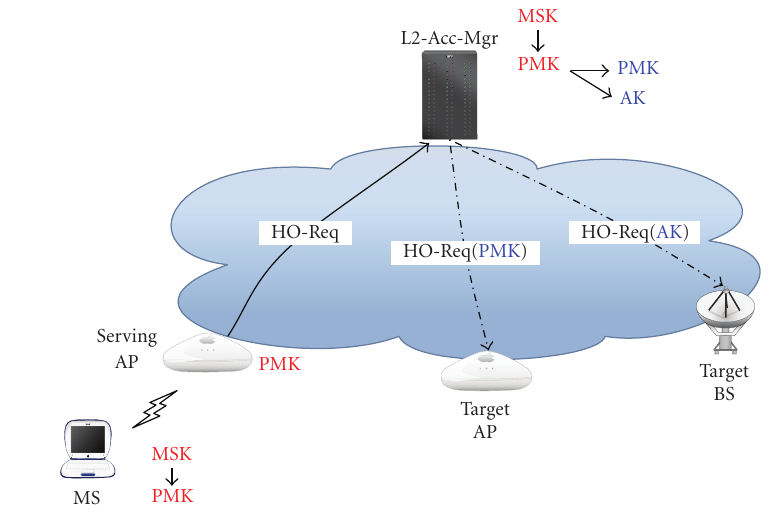
Figure 7: Proactive key distribution, Scenario 2.